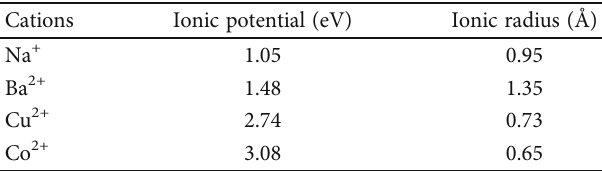
Table 9: Radius and ionic potential of some cations